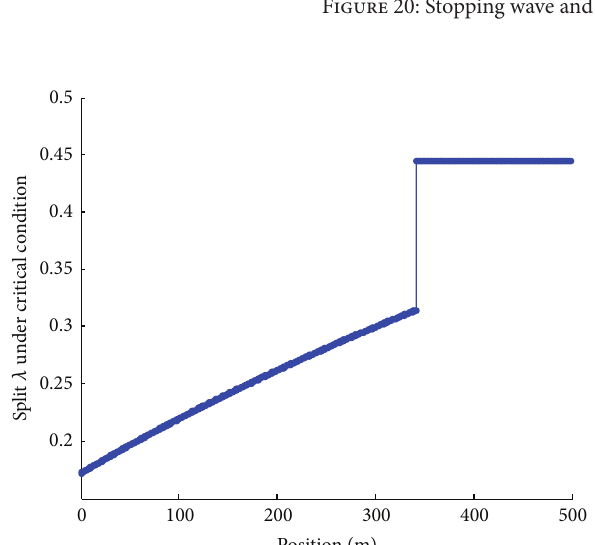
Figure 22: 𝑞 - 𝑘 relationship of two sections.